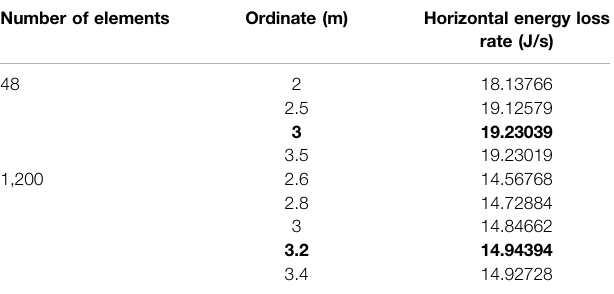
TABLE 1 | Horizontal energy loss rate with different number of elements. Number of elements Ordinate (m) Horizontal energy loss